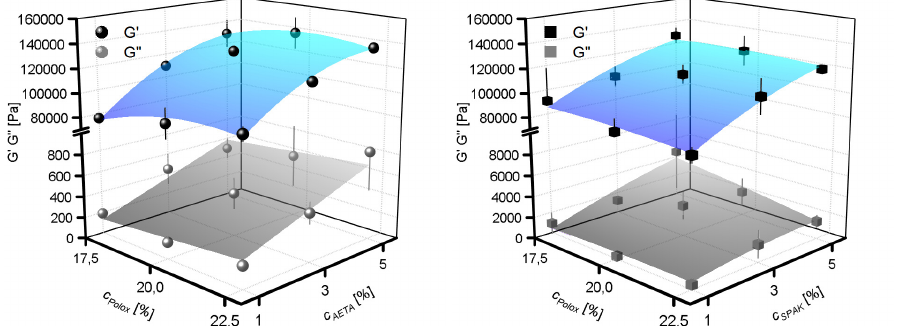
Figure 3. Storage moduli G’ and loss moduli G” of cross-linked hydrogels with varying concentrations of c AETA (positively charged monomers; left ) and c SPAK (negatively charged monomers; right ). The surface fits to the data points are to guide the eye